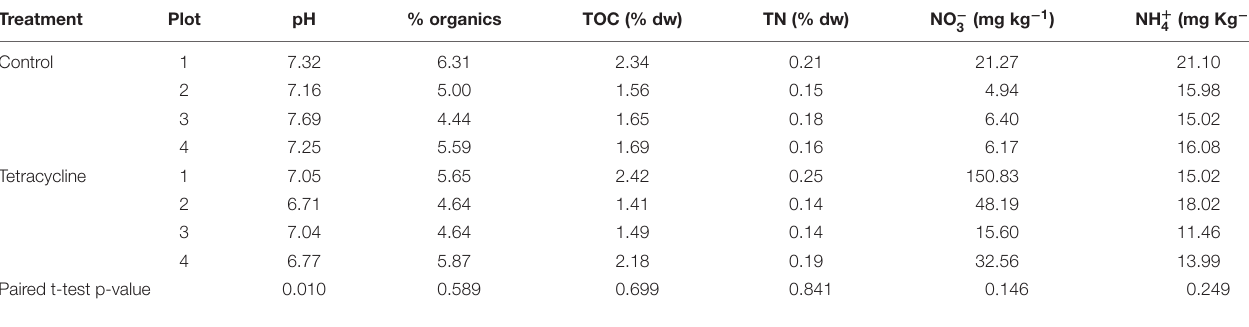
TABLE 1 | Soil properties in samples incubated with and without tetracycline.